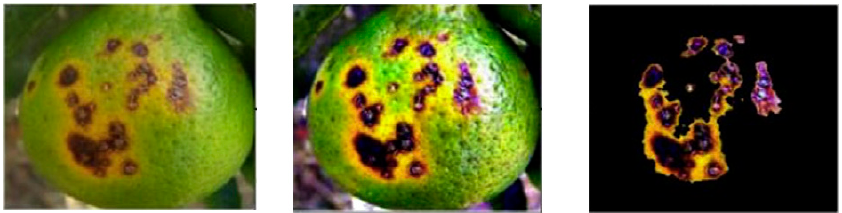
Figure 2. Citrus fruit in a real environment with the infected region of the real image highlighted for map segmentation purposes [25].